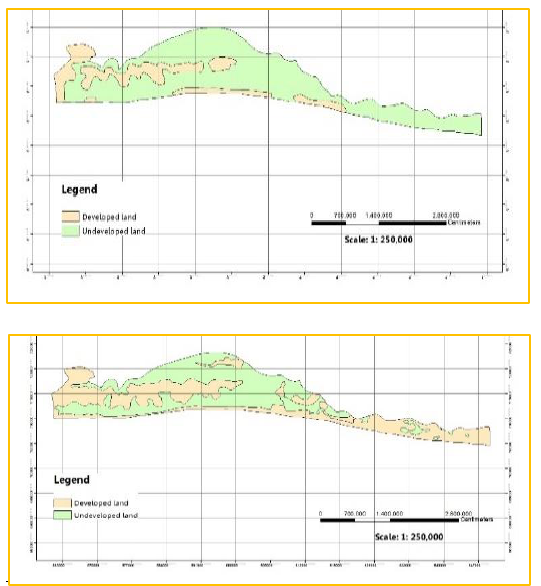
Figure 2. Extent of housing development in Ibeju-Lekki in 2006 and 2016 respectively. Source: Field Survey, 2016.